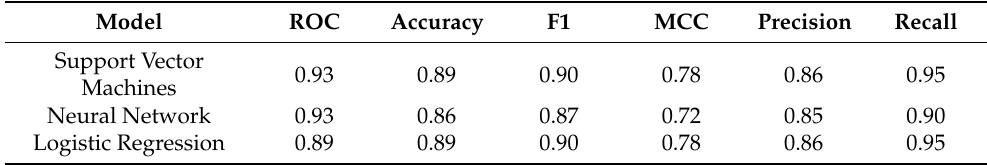
Figure 5. ROC–AUC for the models with higher scores. From left to right, the ROC–AUC is shown for support vector machines ( A ), neural network ( B ) and logistic regression ( C ). ( A ) shows that the ROC-AUC for the support vector machines model is 93%; ( B ) shows that the ROC-AUC for the neural network model is 93%; ( C ) shows that the ROC-AUC for the logistic regression model is 93%. In particular, the general highest scores shown in Table 5 were obtained for the support vector machines with C = 2 2 , gamma = 2 − 7 with the radial basis function kernel. High scores were also obtained by the logistic regression with L1 penalty and the neural network in 200 iterations, with 10 hidden layers at 0.001 learning rate. For each model we also computed the accuracy, F1, Matthews Correlation Coefficient (MCC), precision and recall. Table 5. Models that obtain the best performance.